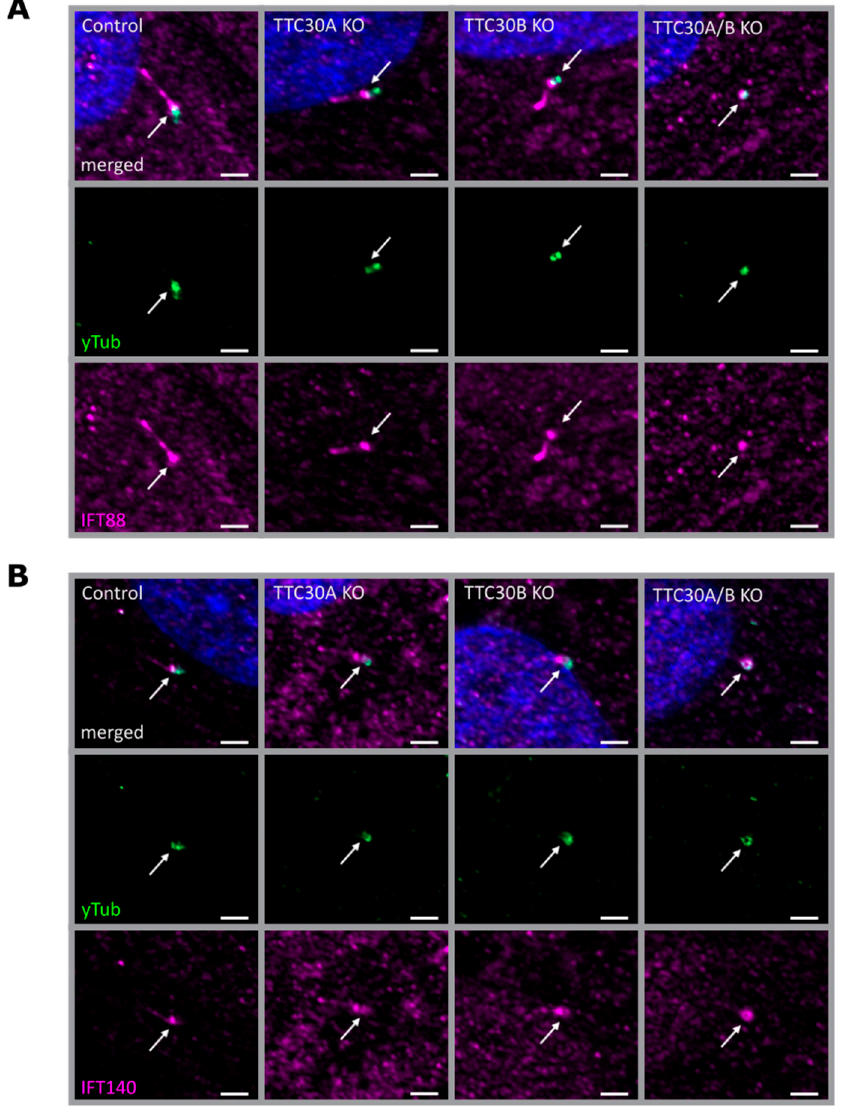
Figure 5. Fluorescent light microscopy pictures of hTERT-RPE1 control, TTC30A, TTC30B and TTC30A/B double-KO cells (from left to right) are shown. The cells were stained for γ -tubulin (green), DNA marked in dark blue and co-localization shown in white. The magenta channel depicts IFT88 ( A ) or IFT140 ( B ). The scale bar measures 2 µm.